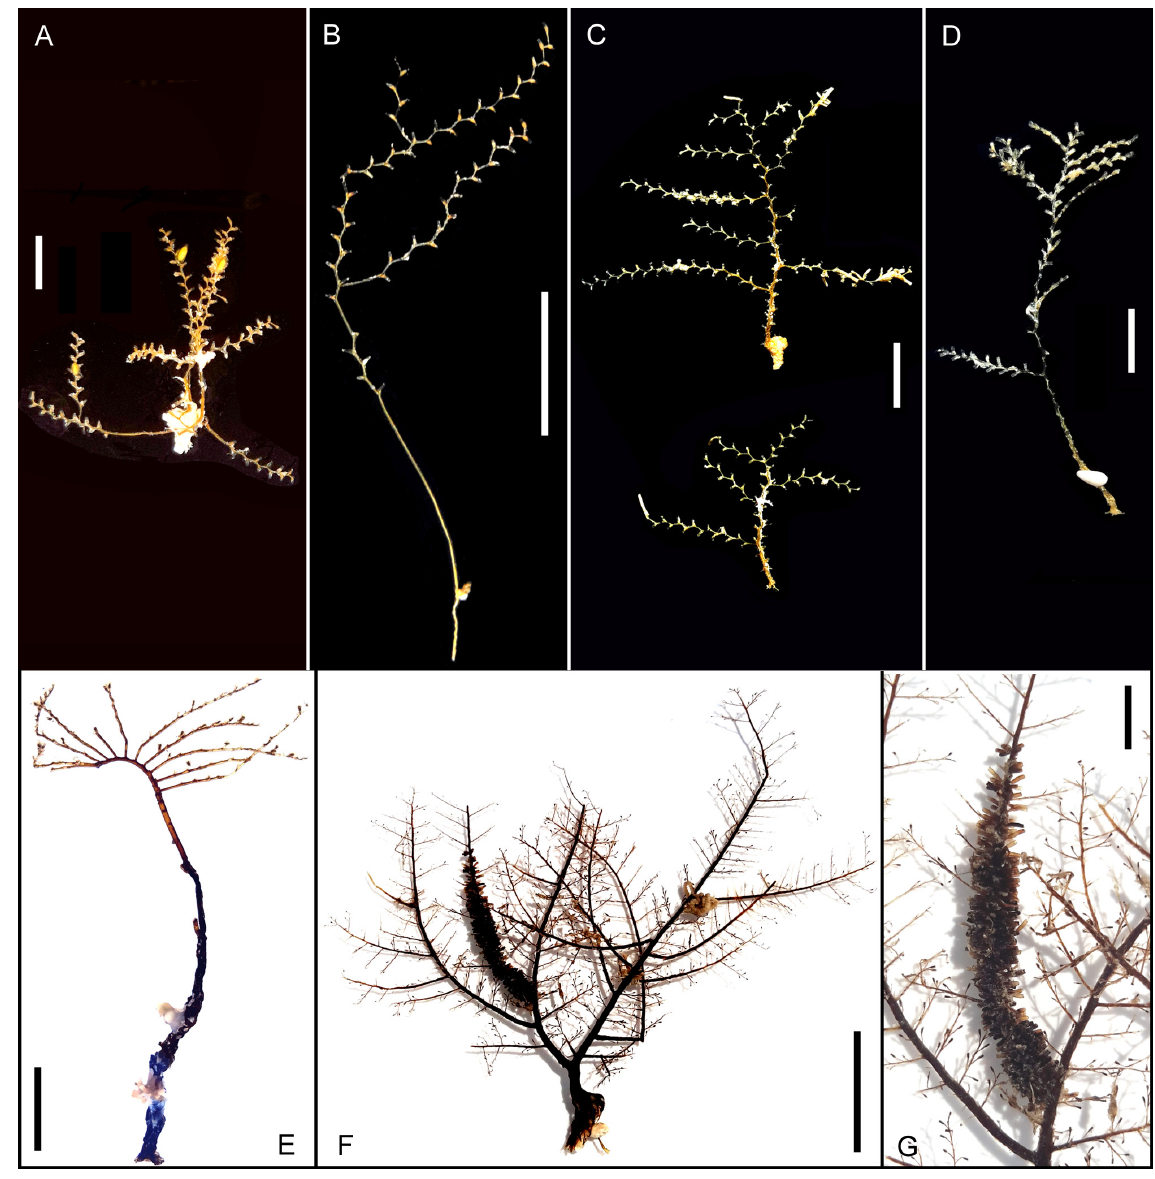
Fig. 16. A . ? Symplectoscyphus acutustriatus Galea, sp. nov., holotype colony, MNHN- IK-2015-460. — B . ? Symplectoscyphus elongatulus Galea, sp. nov., holotype colony, MNHN- IK-2015-463. — C . Symplectoscyphus paulensis Stechow, 1923, colonies from sample MNHN- IK-2015-393. — D . Symplectoscyphus cf. tropicus (Hartlaub, 1901), colony from sample MNHN-IK-2015-394. — E . Tuberocaulus scorpioides (Vervoort, 1993) gen. et comb. nov., colony from sample MNHN-IK-2015-400. — F–G . Zygophylax niger Galea, sp. nov., holotype colony (F) and detail of its coppinia (G) from sample MNHN-IK-2015-478. Scale bars: A, G = 5 mm; B–E = 1 cm; F = 2